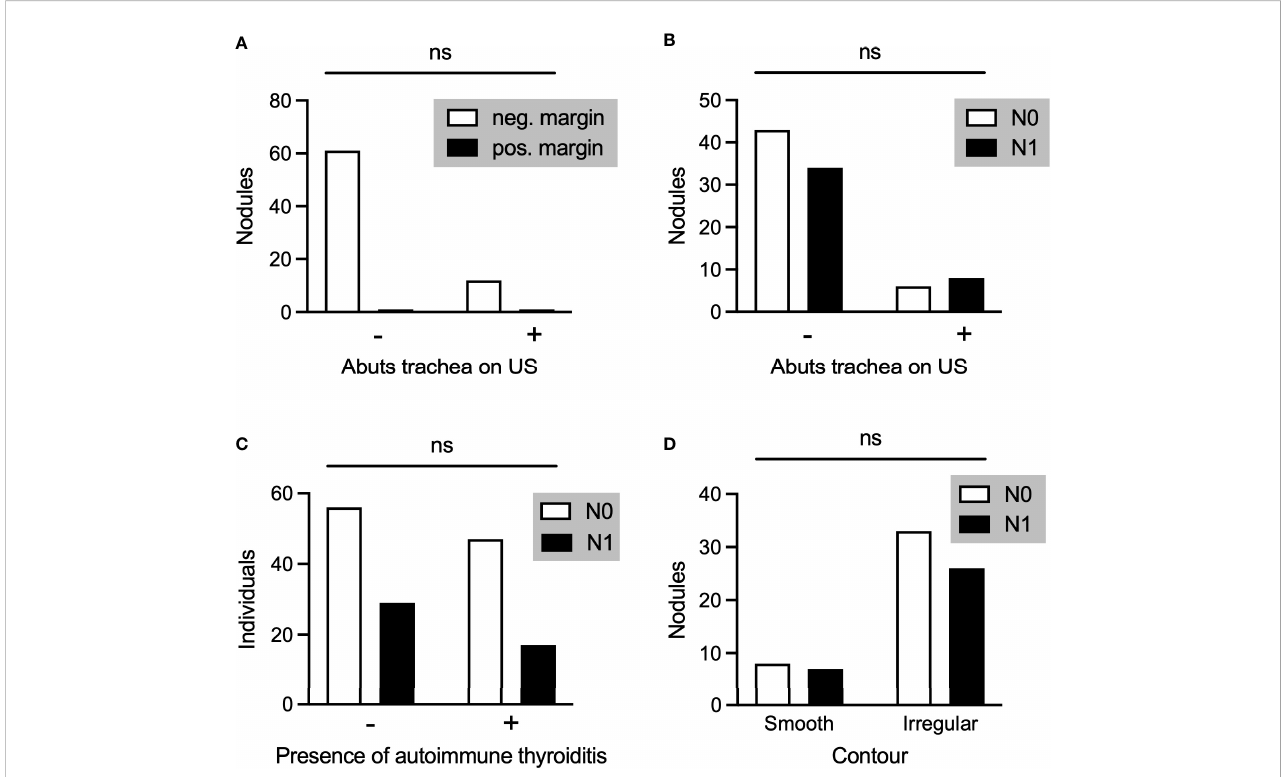
FIGURE 4 (A) PTMC nodules associated with negative or positive pathological margins in those nodules that did (+) or did not (-) abut the trachea on preoperative ultrasound. (B-D) Comparison of PTMC nodules associated with N0 or N1 disease with regard to whether the nodule abutted the trachea (B) , the individual had autoimmune thyroiditis (C) , and the contour of the nodule (D) . ns, not stastistically signi fi